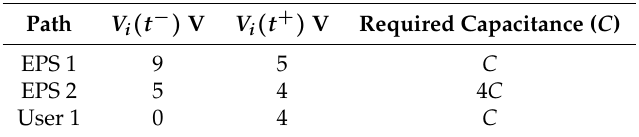
Table 6. Parameters’ setup and the required number of supercapacitors when the voltage differences of EPS 1 and EPS 2 are